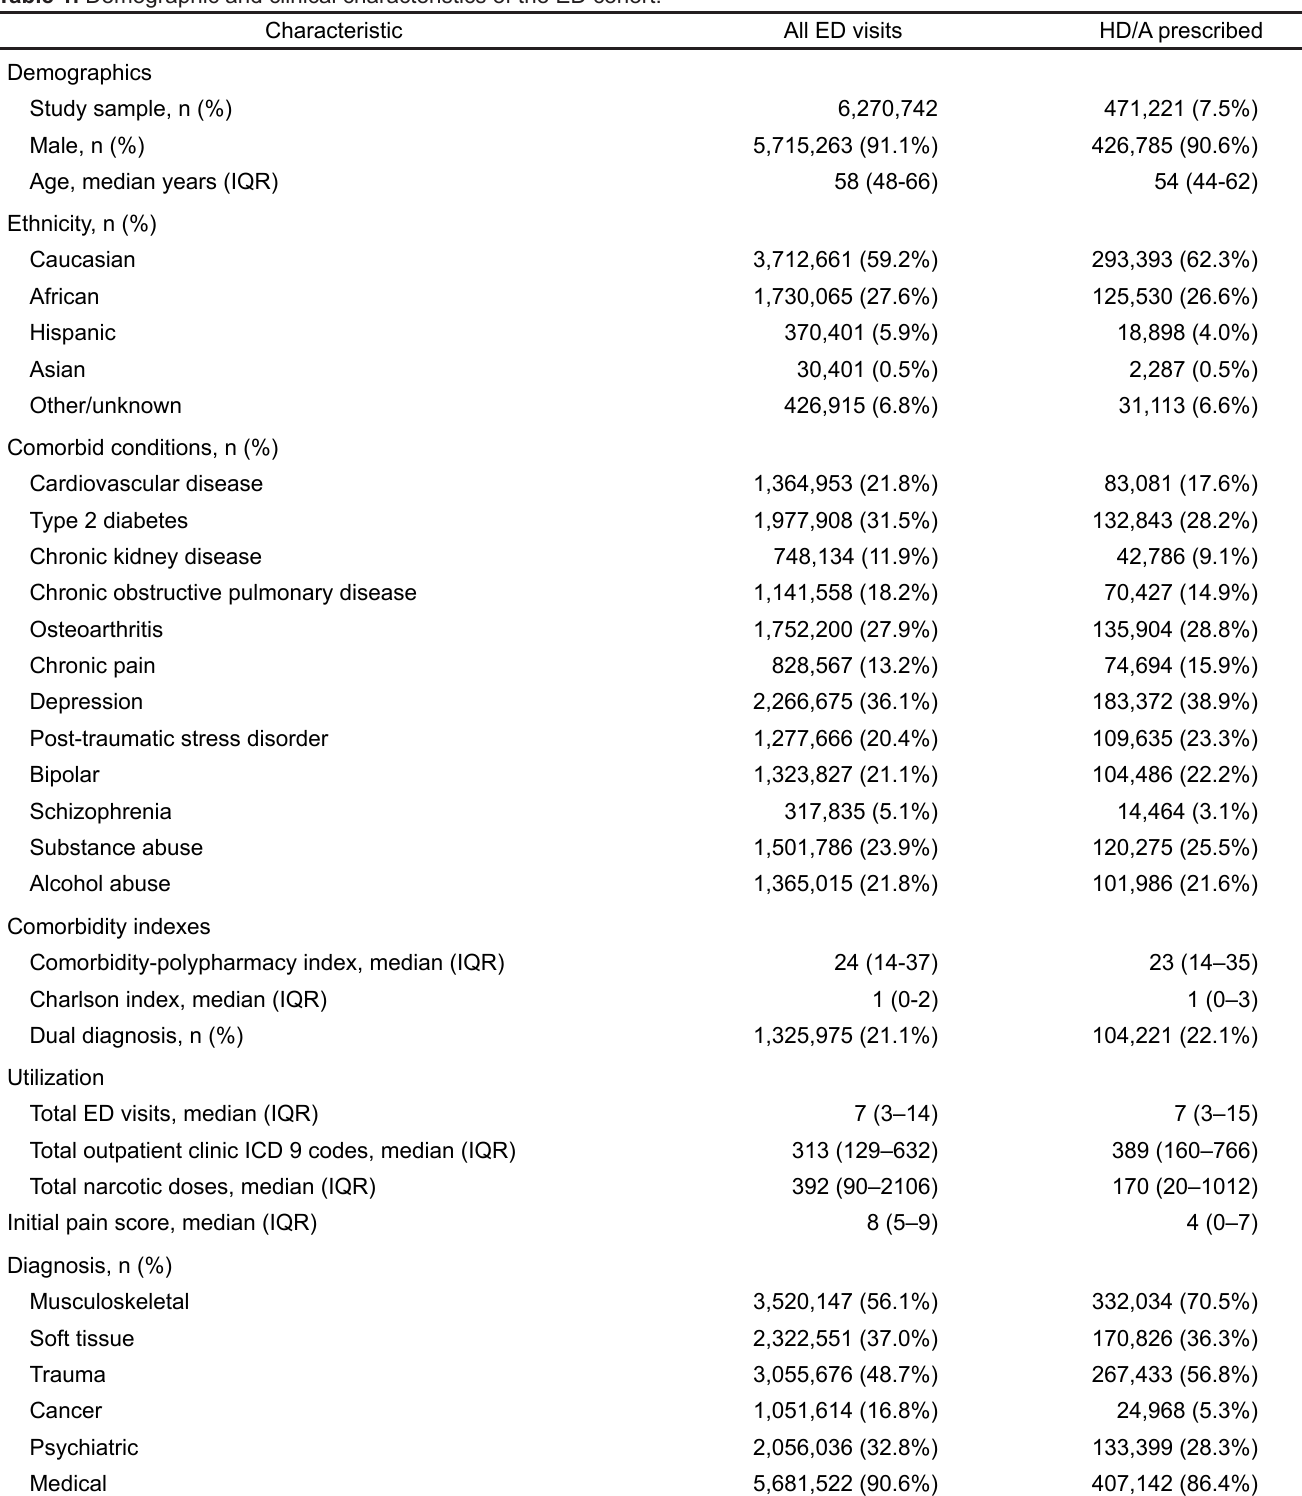
Table 1. Demographic and clinical characteristics of the ED